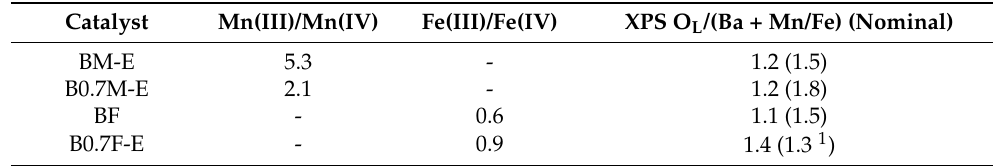
Figure 4. XPS spectra of the Mn 2p 3/2 ( a ) and Fe 2p 3/2 ( b ) transitions for BM-E, B0.7M-E, BF, and B0.7F-E catalysts. Table 3. XPS data for BM-E, B0.7M-E, BF, and B0.7F-E catalysts.